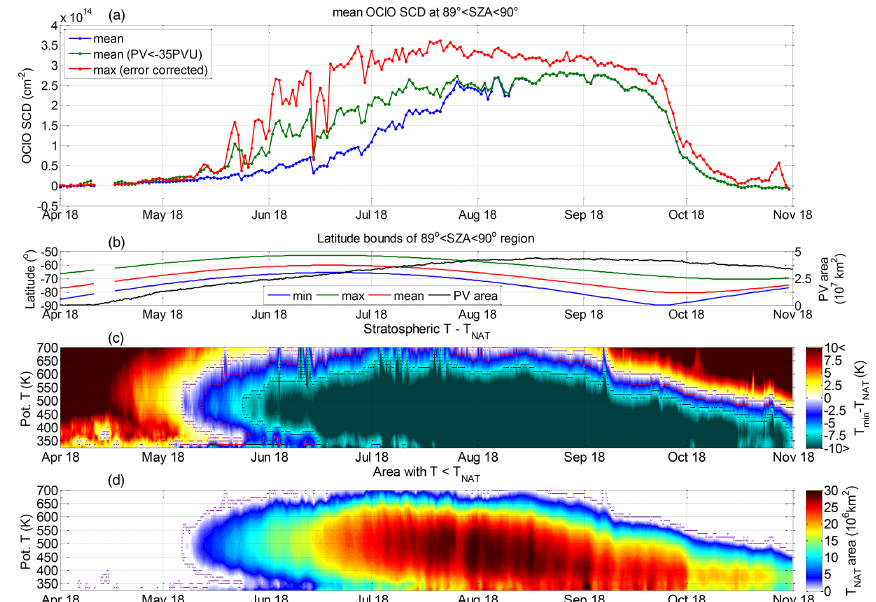
Figure 9. Same as Fig. 3 but for the Arctic winter 2019/20.